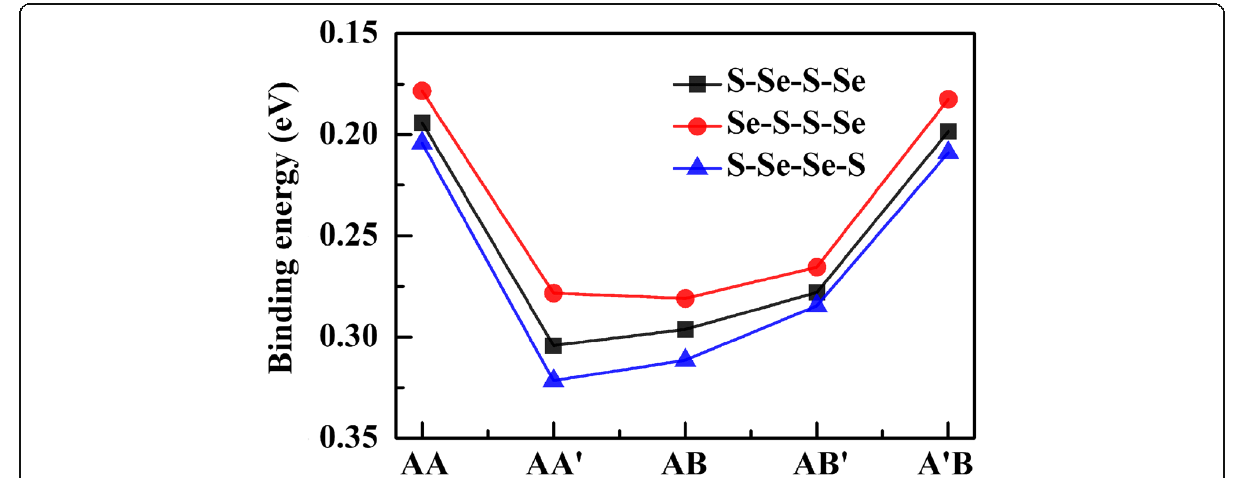
Fig. 2 Binding energies of all the equilibrium geometric configurations of WSSe bilayer